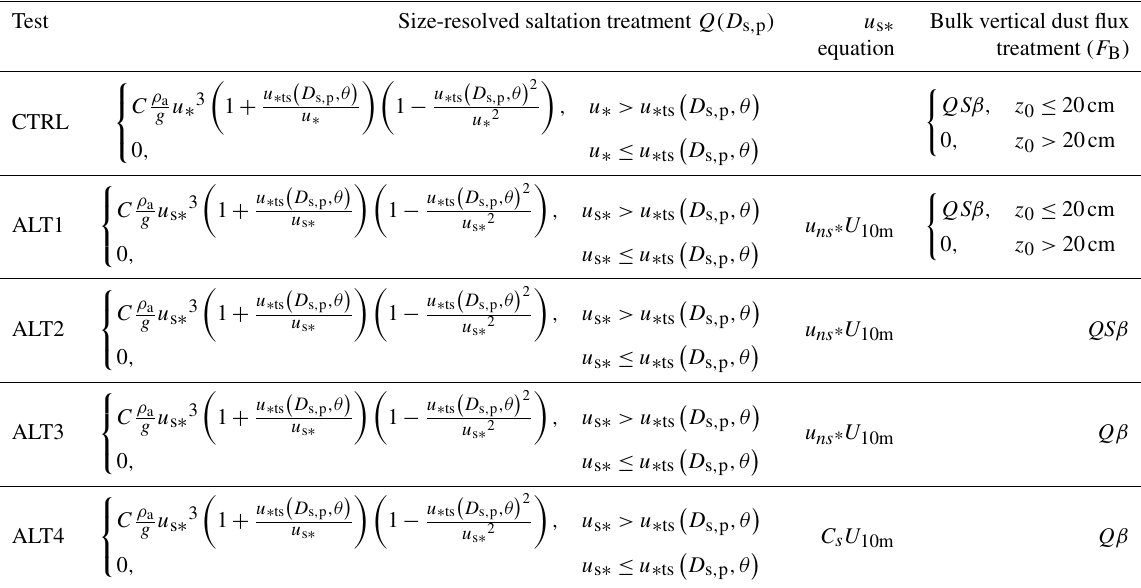
Figure 4. Important terrain attribute features considered in the AFWA dust emission flux calculation, including (a) soil sand mass fraction, (b) soil clay mass fraction ( m clay ), (c) the clay mass fraction threshold affecting dust emission, (d) dust source strength ( S ; gray areas are masked), (e) the threshold aerodynamic roughness length ( z 0 ) required for dust emission, and (f) sandblasting efficiency ( β ). Note that β (panel f ) is relatively homogenous due to the clay-rich soil content of the domain and is capped at 1.06 × 10 − 6 cm − 1 , where the soil composition exceeds 20% clay content. The black × marks the location of Phoenix, Arizona. Table 4. Size-resolved saltation and bulk vertical dust flux treatments associated with each test